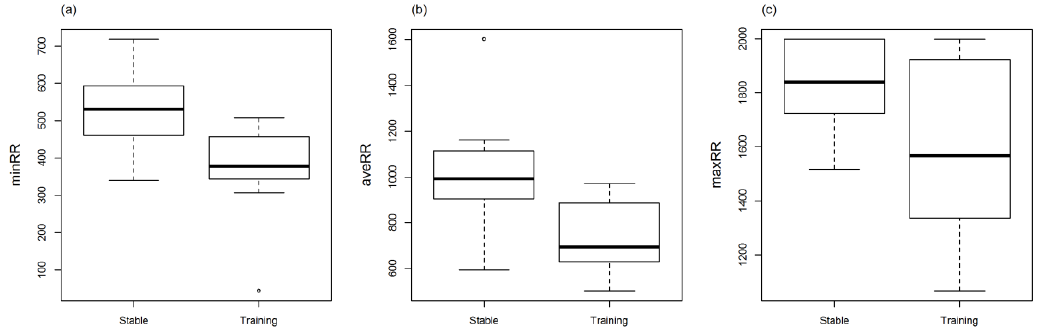
Figure 1. Minimum ( a ), average ( b ), and maximum ( c ) beat-to-beat (RR) intervals (ms) of horses before training (Stable) and during Monty Roberts’ public demonstration (Training). RR intervals were significantly lower in training than in the stable (minimum: p = 0.0006, average: p = 0.01, maximum p = 0.03). Analysed using generalized linear mixed models (GLMM).